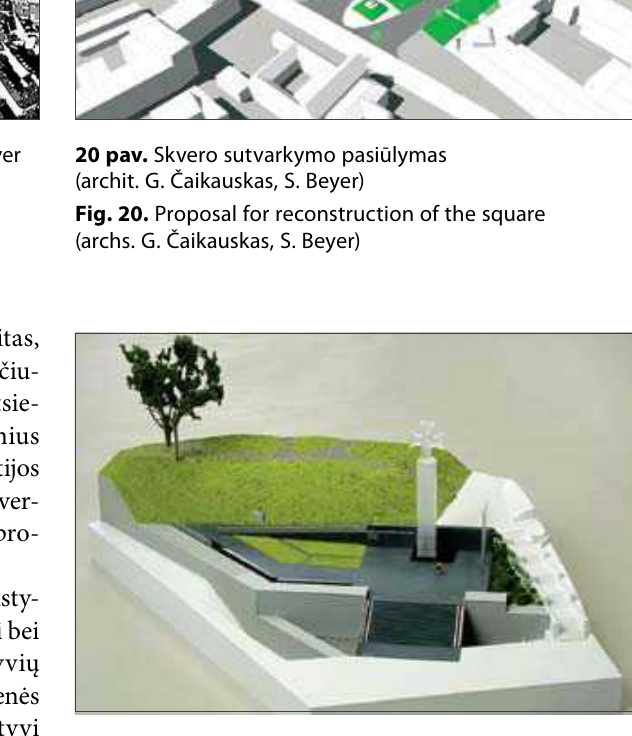
Fig. 21. Monument of estonian Independence in the centre of tallinn by a footpath